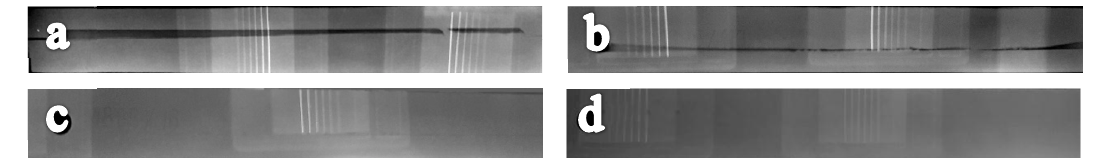
Figure 10. Radiography scan at ( a ) 600 rpm with a welding rate of 16 mm/min, ( b ) 1500 rpm with a welding rate of 52 mm/min, ( c ) 1200 rpm with a welding rate of 52 mm/min, and ( d ) 1200 rpm with a welding rate of 32 mm/min.